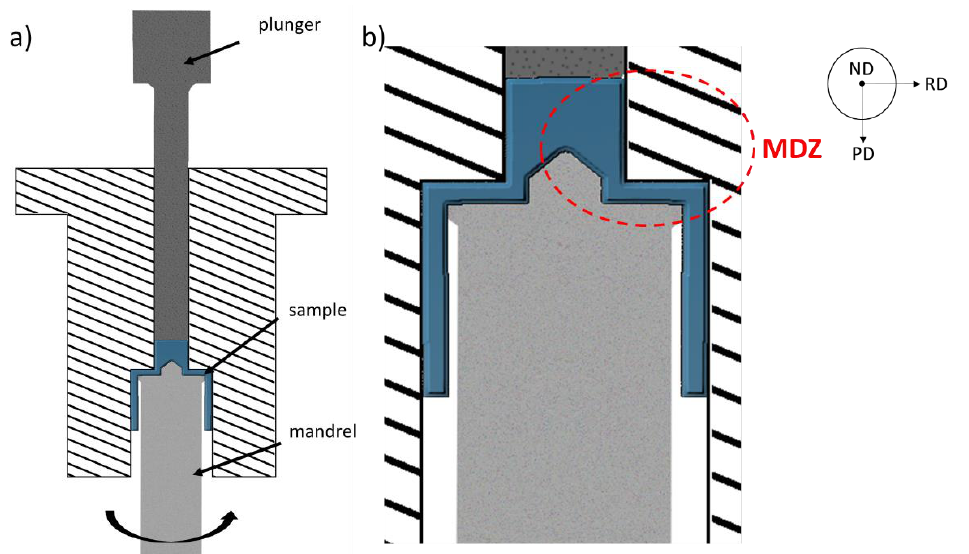
Figure 1. Scheme of the CSET device ( a ) and its detail ( b ) showing the main deformation zone (MDZ). PD—pressing direction, RD—radial direction, ND—normal direction. PD—pressing direction, RD—radial direction, ND—normal